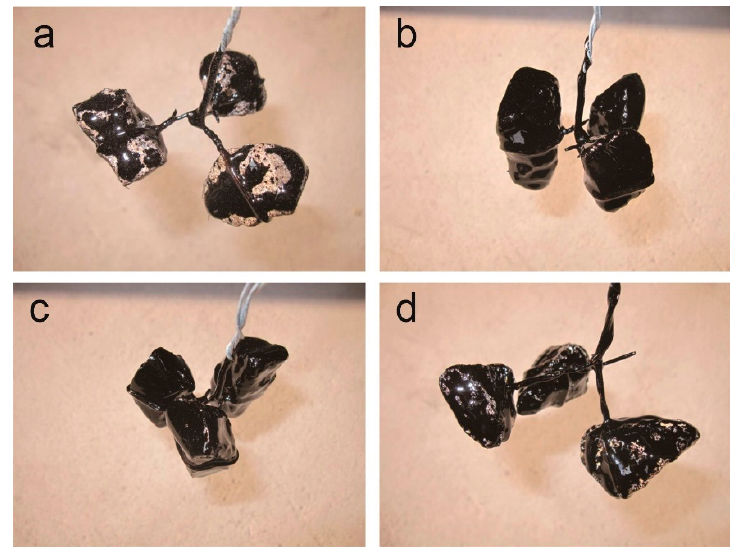
Figure 5. Adhesion test results between acidic aggregates and ( a ) matrix asphalt of SK-90#, ( b ) SK-90-OMMT/PAR, ( c ) SK-90-ASA-1 and ( d ) SK-90-ASA-2. Table 8. Adhesion grades of KL-90 asphalt modified by anti-stripping composites and granite. Asphalt Kinds Aging Methods